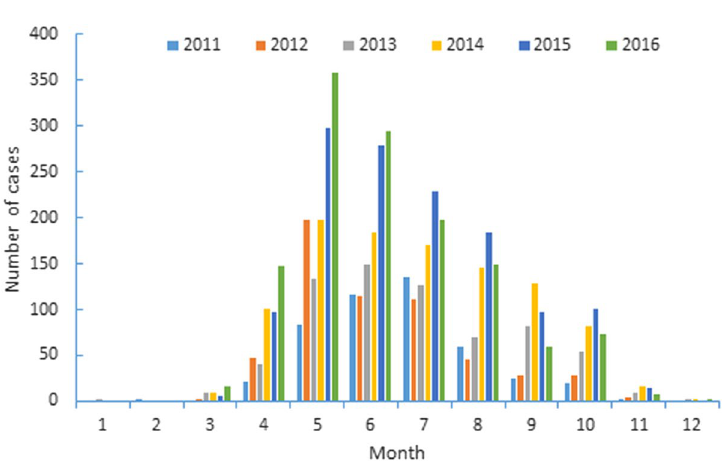
Figure 3. Seasonal distribution of SFTS cases in China from 2011 to